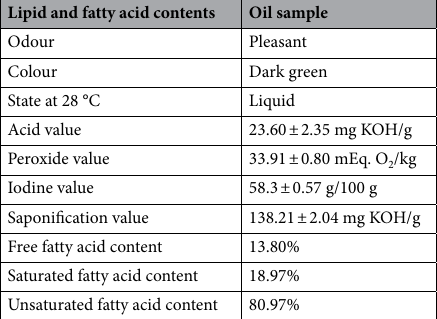
Table 2. Lipid and fatty acid contents of the C. schweinfurthii pulp